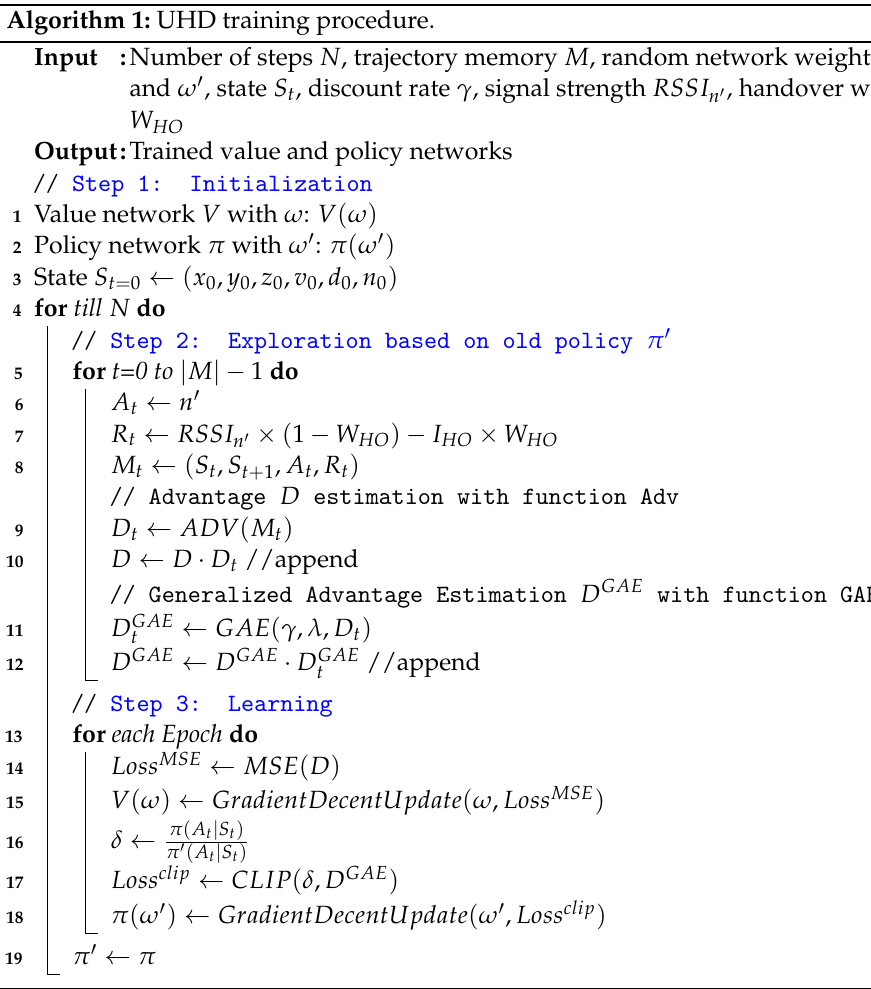
Algorithm 1: UHD training